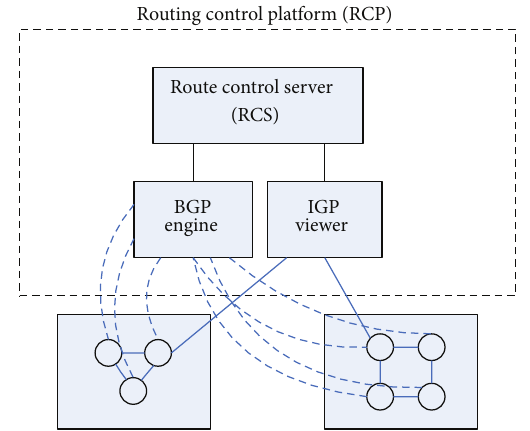
Figure 2: Schematic structure of the routing control